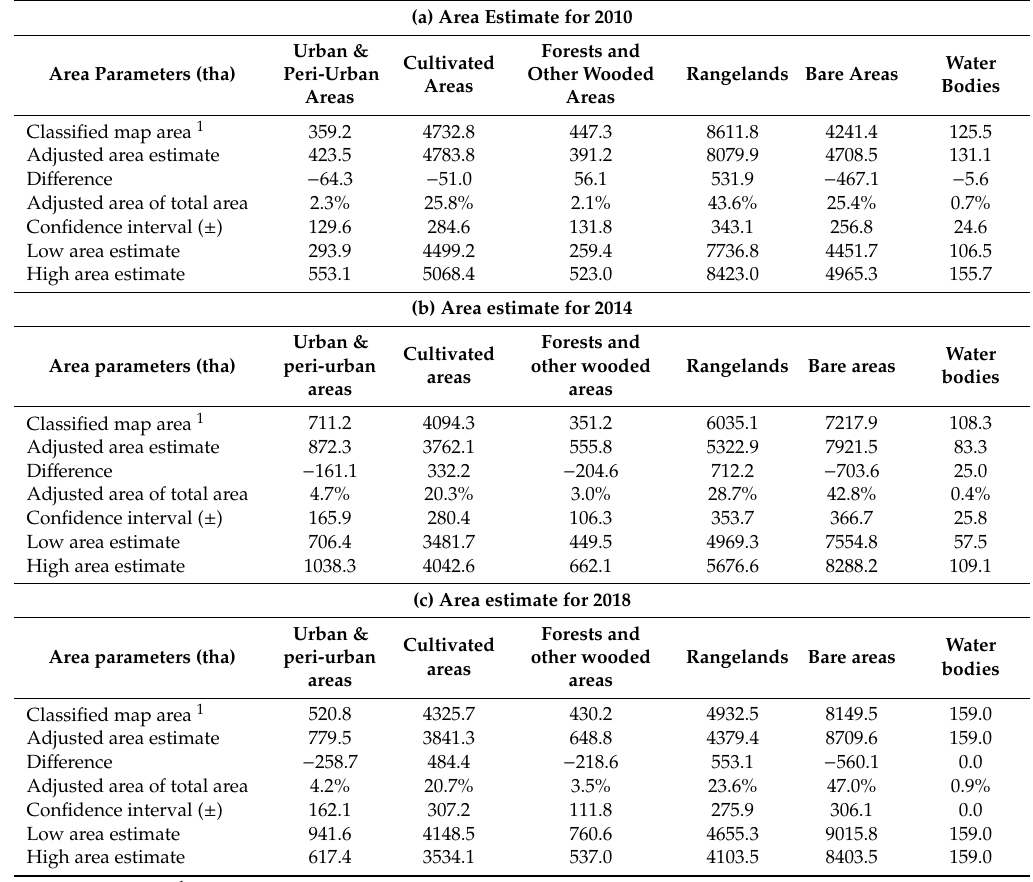
Table 5. Area estimates in thousand ha (tha) and percentage share (%) of each LULC category between 2010 and 2018 in Syria (after computing adjusted area